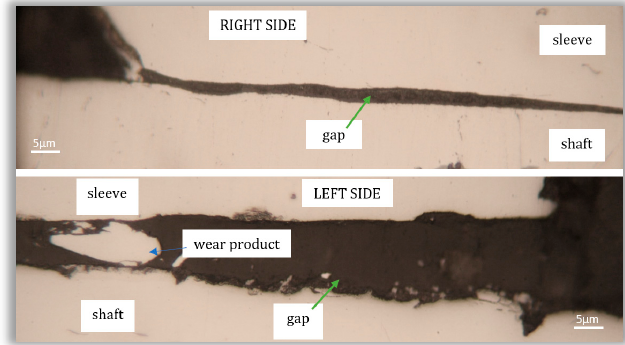
Figure 13. Microscopic image of the gap between the shaft and sleeve.